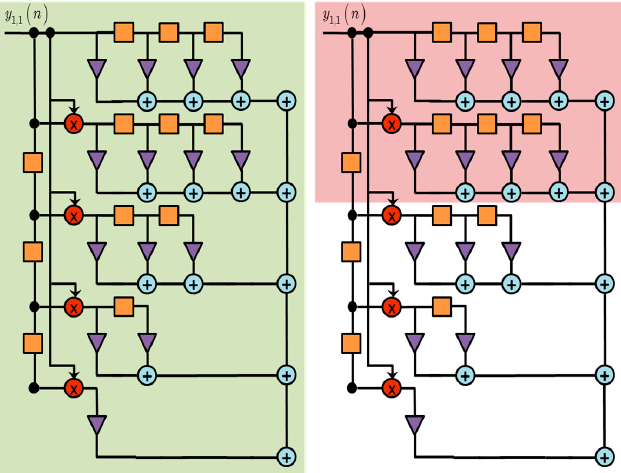
Figure 5. The differences in FF part structure for an equalizer of M f = 4 between ( a ) VDFE and ( b ) SVDFE.